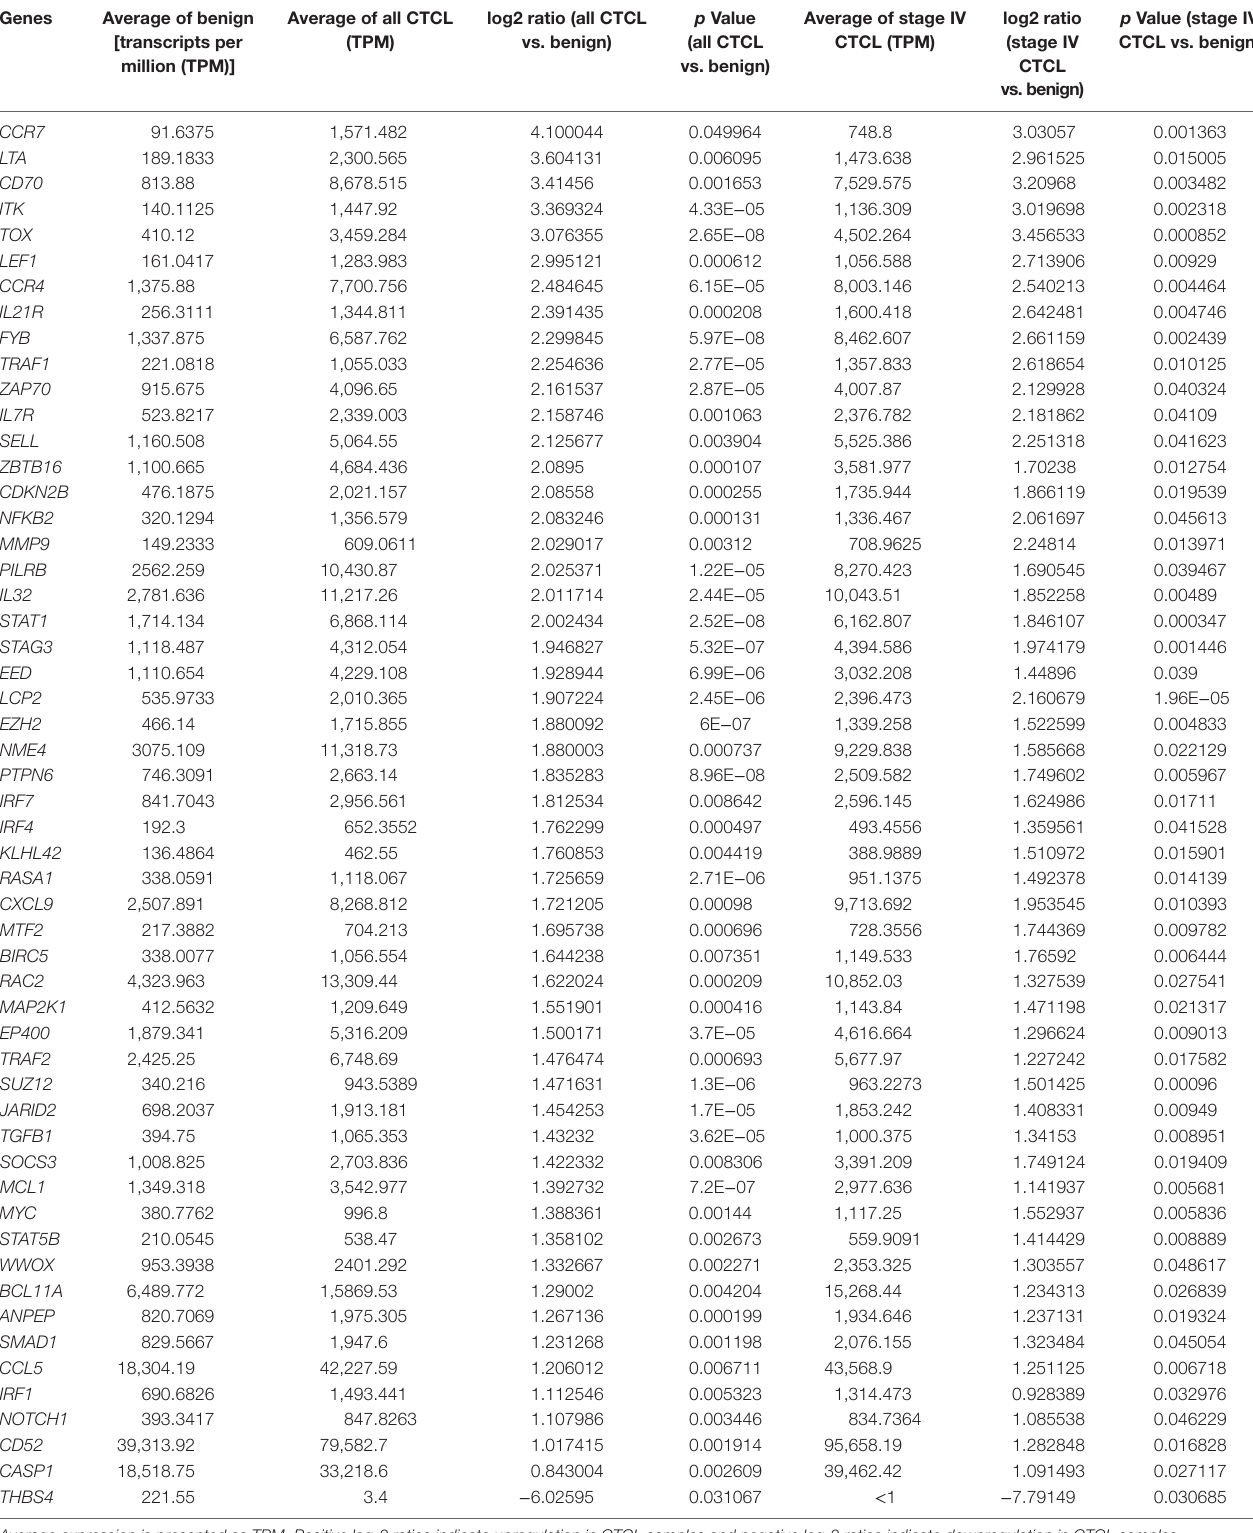
TaBle 1 | Genes with statistically significant differences in expression both between benign skin dermatoses vs. all ≤ 2008 CTCL samples (left panel) and between benign skin lesions vs. ≤ 2008 stage IV CTCL samples (right panel). genes average of benign [transcripts per million